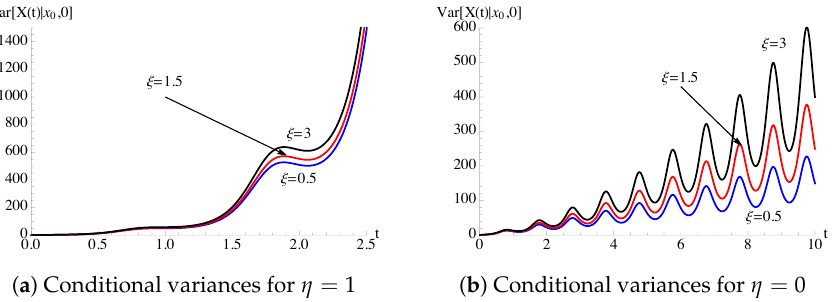
Figure 11. For the process of Figure 7, the conditional variances are plotted as function of t for various choices of ξ